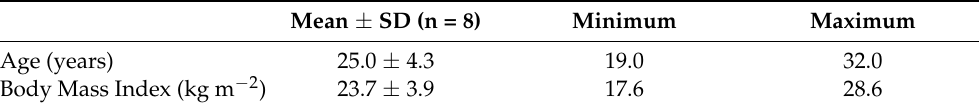
Table 1. Participant demographics.